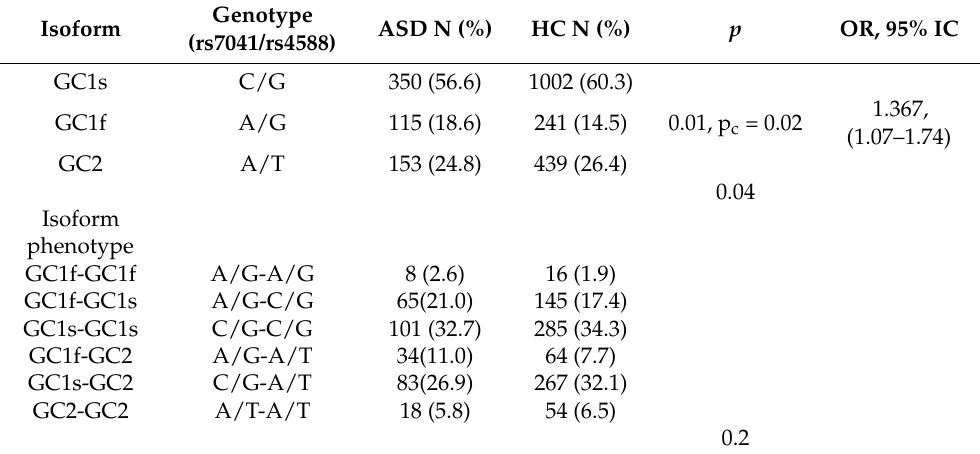
Table 2. GC isoform genotype and phenotype distribution in ASD children and healthy controls